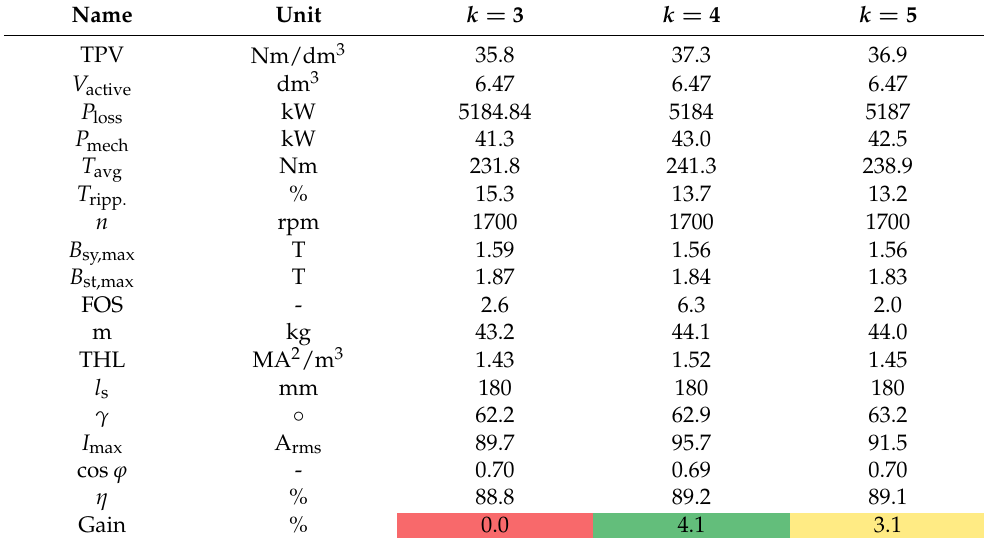
Table 7. Comparison table of MZhVD topology performance for k = 3–5.